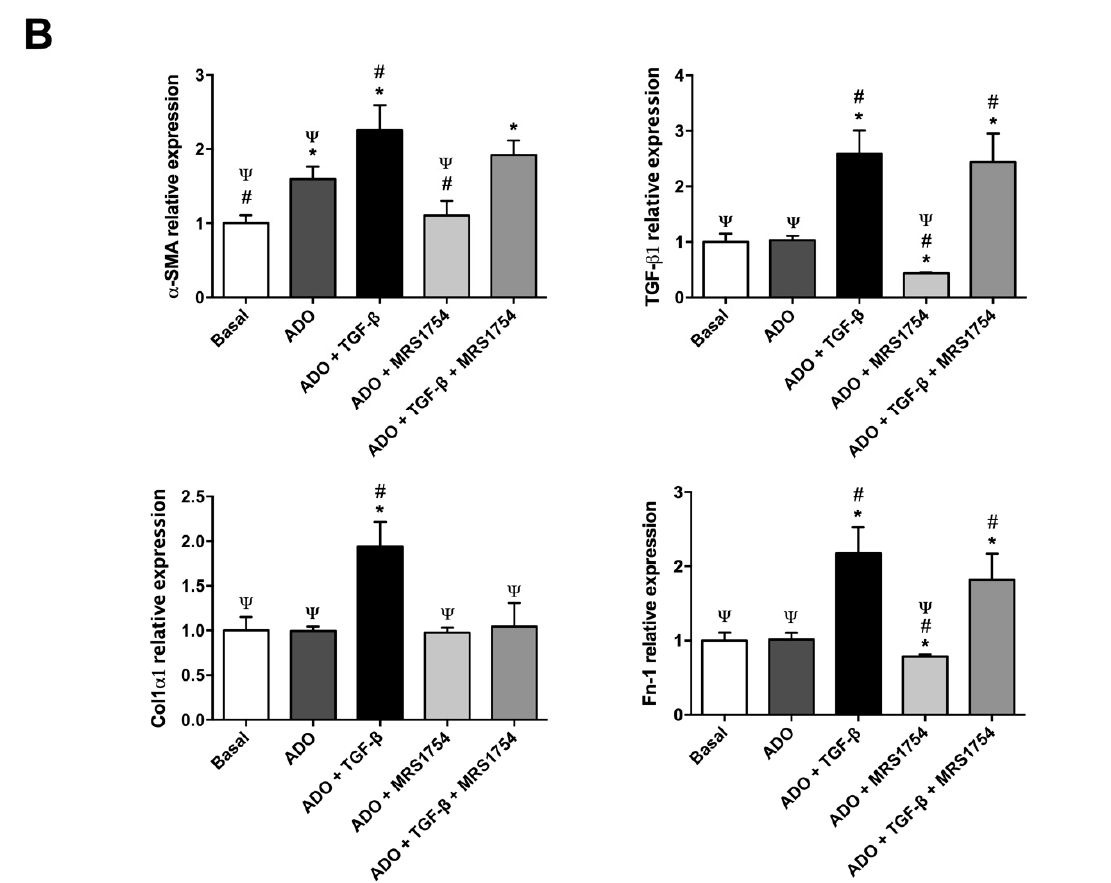
Figure 6. In vitro blockade of A 2B AR decreased myofibroblast marker expression in macrophages. ( A ) Immunocytofluorescence of macrophage (F4/80 and CD68; green) and myofibroblast ( α -SMA and Col1 α 1; red) markers in human macrophages cultured in Roswell Park Memorial Institute (RPMI) high D-glucose medium 0.5% FBS (basal) treated with 1 μ M adenosine (ADO), 10 ng/mL TGF- β 1, and 10 nM MRS1754 for seven days. DAPI (blue) was used as a counterstain. Cells selected from the image captured with a 400× magnification. ( B ) mRNA expression of myofibroblast markers α -SMA, TGF- β 1, Col1 α 2, and Fn-1 by RT-qPCR in human macrophages cultured under basal condition, adenosine (ADO), TGF- β 1, and MRS1754 for seven days. HPRT mRNA expression was used for normalization. Graphs represent the mean ± S.D. * p < 0.05 versus basal; # p < 0.05 versus ADO; Ψ p < 0.05 versus ADO + TGF- β 1. n = 3.